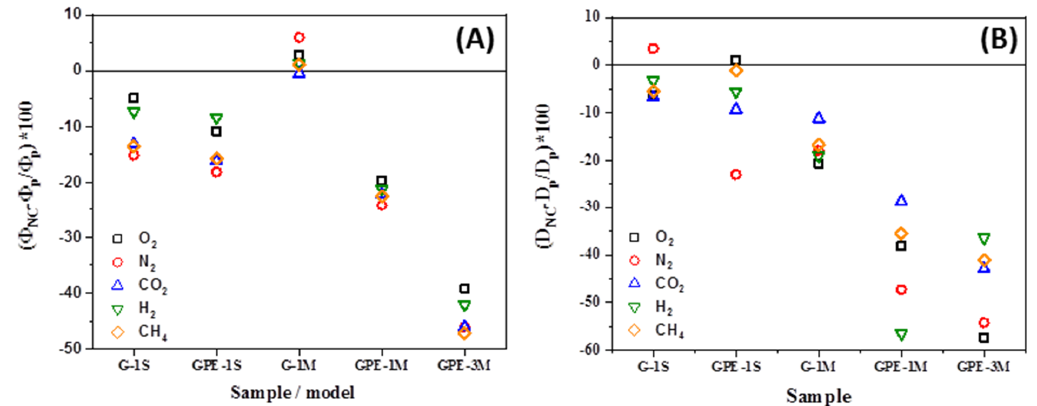
Figure 7. Improvement of the gas barrier properties ( A ) and variation of the diffusion coefficient ( B ) of the nanocomposites with respect to a HDPE membrane.